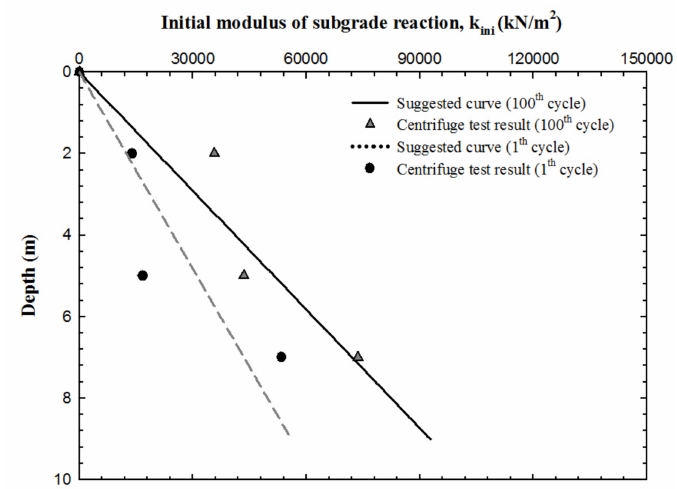
Figure 15. Initial modulus of subgrade reaction by depth at a relative density of